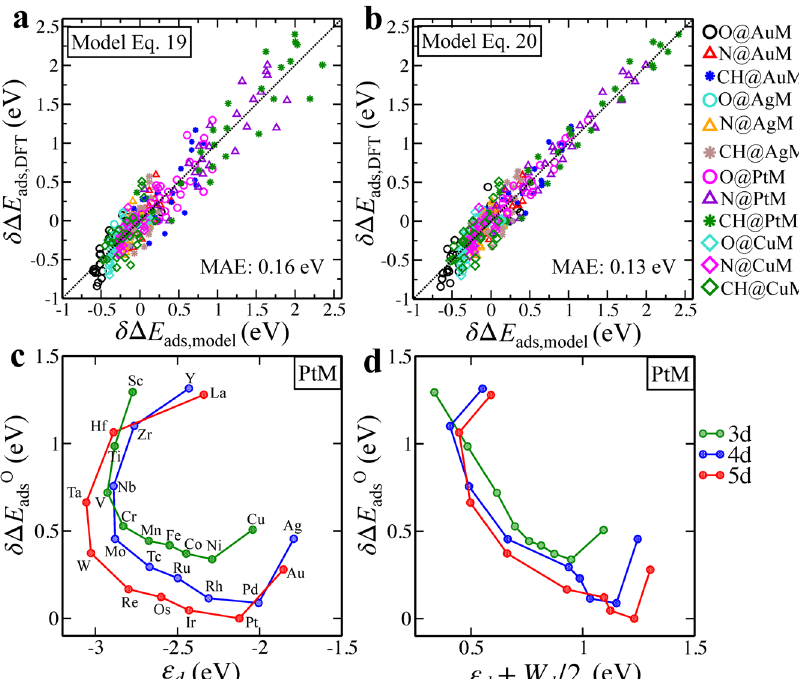
Fig. 8 Prediction of adsorbation energies using the model. a , b Predicted adsorbation energies of O, N, and CH on Au, Ag, Cu, and Pt NSAs using the models in Eqs. (19) and (20), respectively. The predicted energies are plotted against those obtained with DFT. The black dotted line indicates parity. c , d Show the variation of O adsorption energies on Pt NSAs as a function of ε d and ε d + W d /2, respectively. All the values for ε d and ε d + W d /2 are listed in Supplementary Tables 1 –